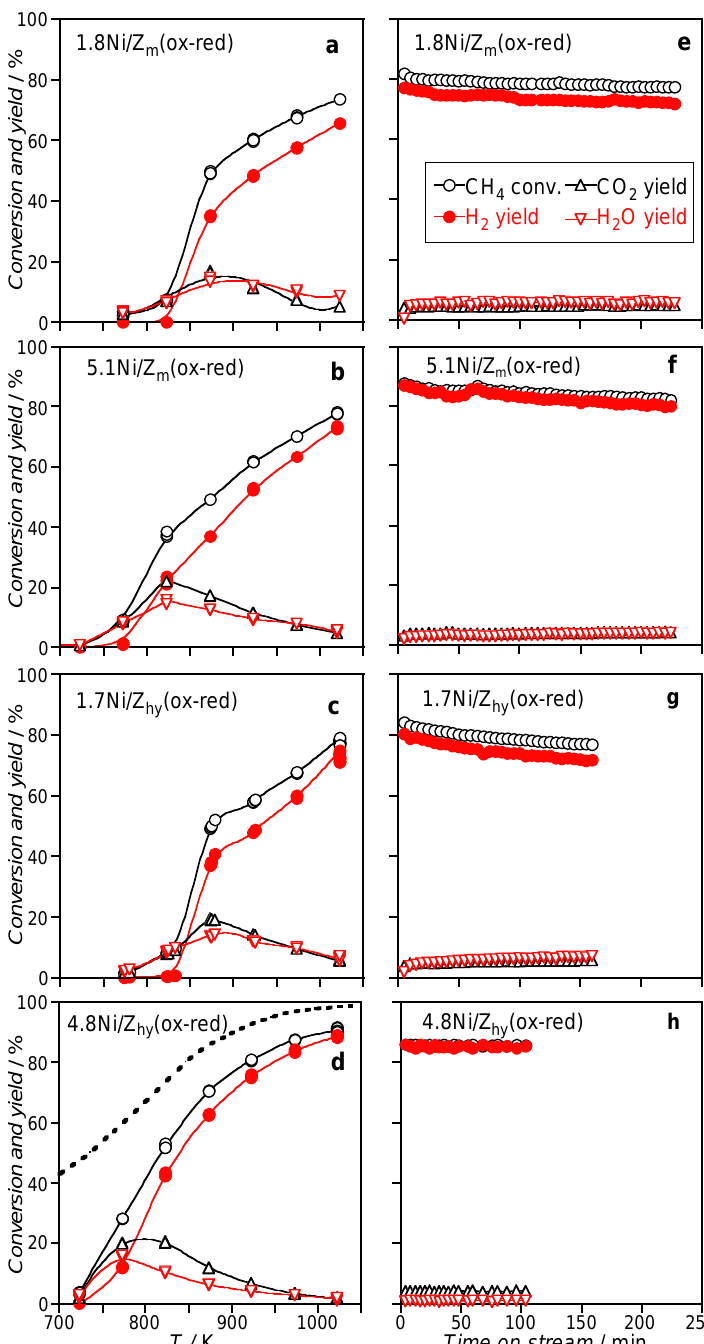
Figure 11. Catalytic activity (CH 4 conversion and H 2 , CO 2 and H 2 O yields) of Ni/ZrO 2 catalysts after ox-red activation treatment in experiments as a function of temperature (left side: ( a – d )) or as a function of time on stream at 1023 K (right side: ( e – h )). Reactant mixture: [CH 4 ] = 2%, [O 2 ] = 1%, N 2 as balance; total flow rate = 150 cm 3 (STP) · min − 1 . Dotted line: CH 4 conversion for the same mixture calculated at thermodynamic equilibrium (data from Ref. [11]).